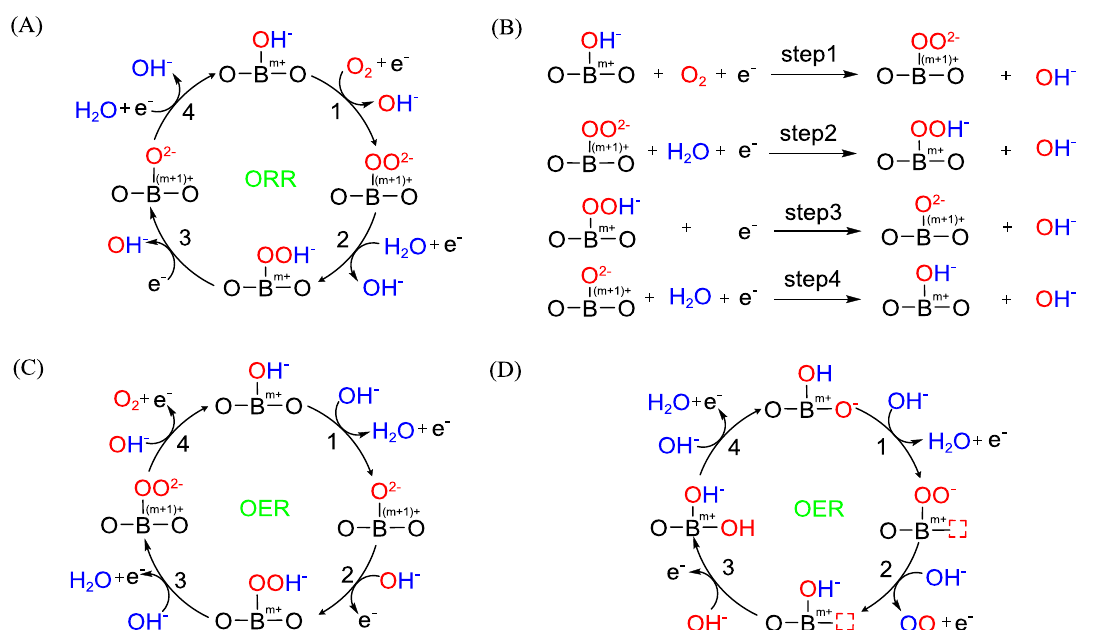
Figure 1. Proposed ( A ) Oxygen reduction reaction (ORR) mechanism (reproduced from [16], with permission from springer Nature, 2011 ) for perovskite electrocatalysts. ( B ) the detailed steps of ORR by equations. ( C , D ) Two different Oxygen evolution reaction (OER) mechanisms proposed for perovskite electrocatalysts (reproduced from [26]).